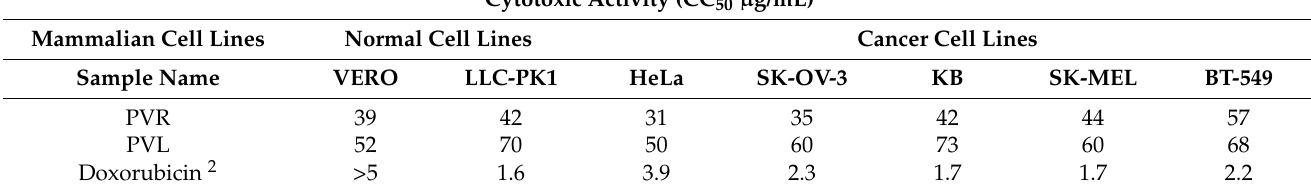
Table 1. Cytotoxicity of root (PVR) and leaf (PVL) extracts of Pulsatilla vulgaris in a panel of normal and cancerous mammalian cell lines tested after 48h incubation using the neutral red assay (normal cell lines: VERO—kidney fibroblast, LLC-PK1—kidney epithelial; cancer cell lines: HeLa—cervical carcinoma, SK-OV-3—ovarian carcinoma, KB—epidermal carcinoma, SK-MEL—skin melanoma, BT-549—breast